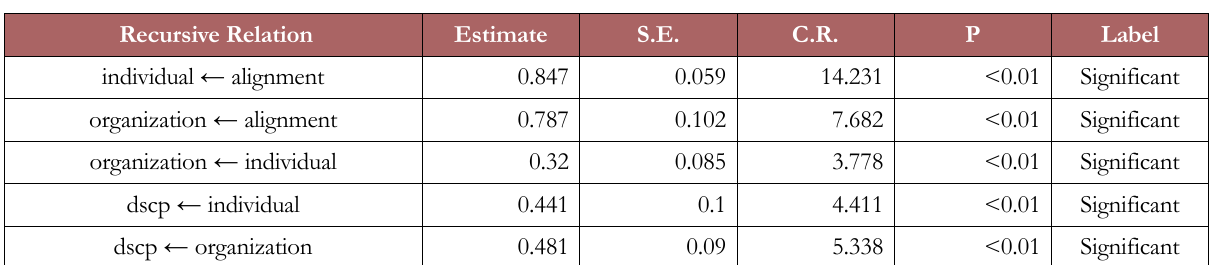
Table 4. Significance Test Result